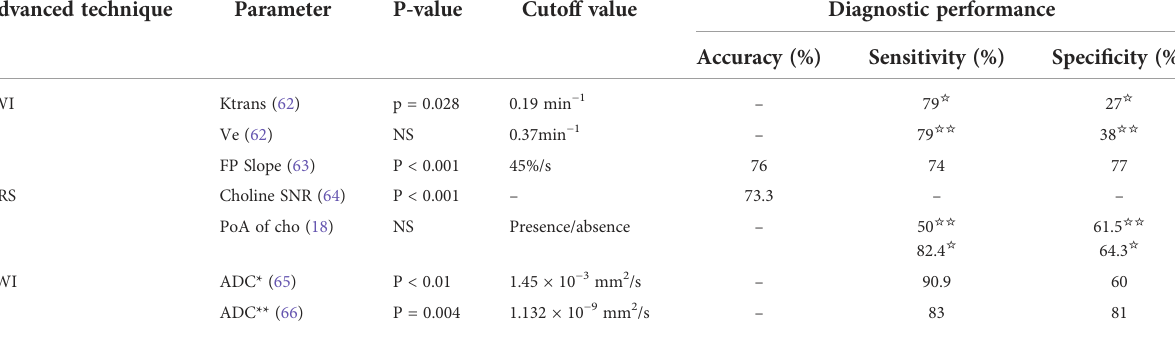
TABLE 3 Advanced functional MRI techniques (PWI, MRS, and DWI) to differentiate benign and malignant musculoskeletal tumor and their sensitivities and speci fi cities. Advanced